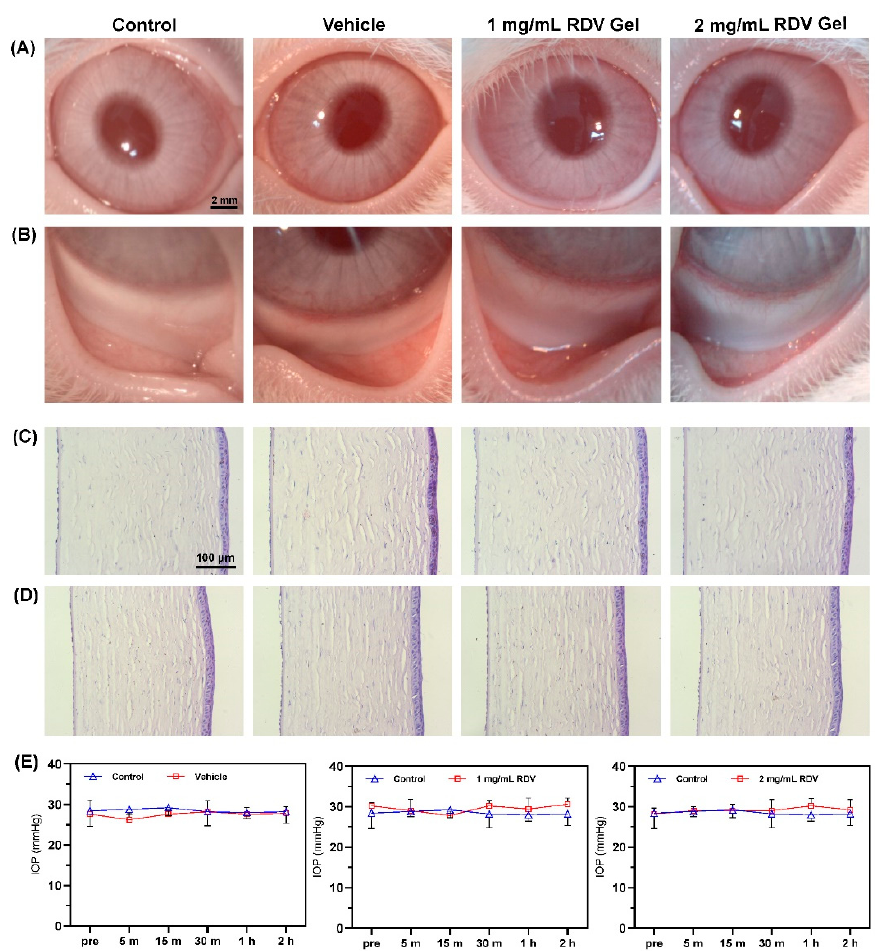
Figure 8. Ocular irritation observation and histological evaluation: ( A , B ) corneal and conjunctival toleration under the slit-lamp microscope; ( C , D ) H&E staining of center and peripheral region of cornea; ( E ) IOP of rabbits after treatment.